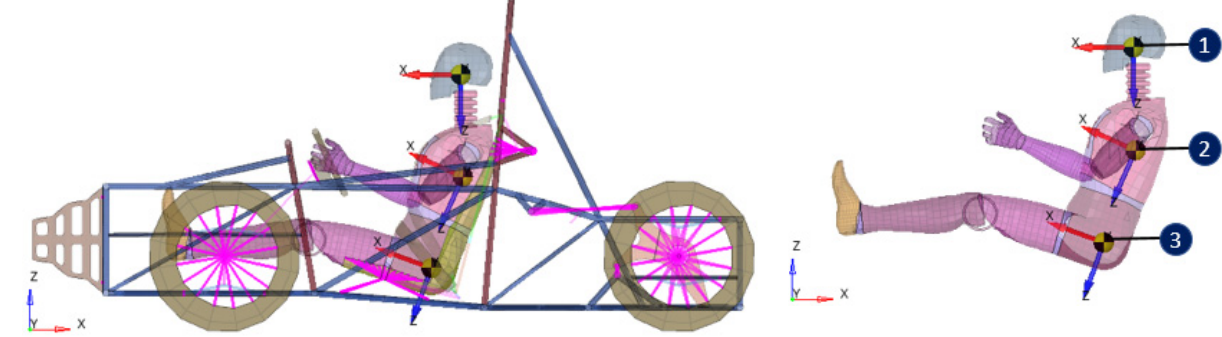
Figure 5. Frontal collision of the car with a wall and the position of accelerometers (1—Head, 2—Thorax and 3—Pelvis).